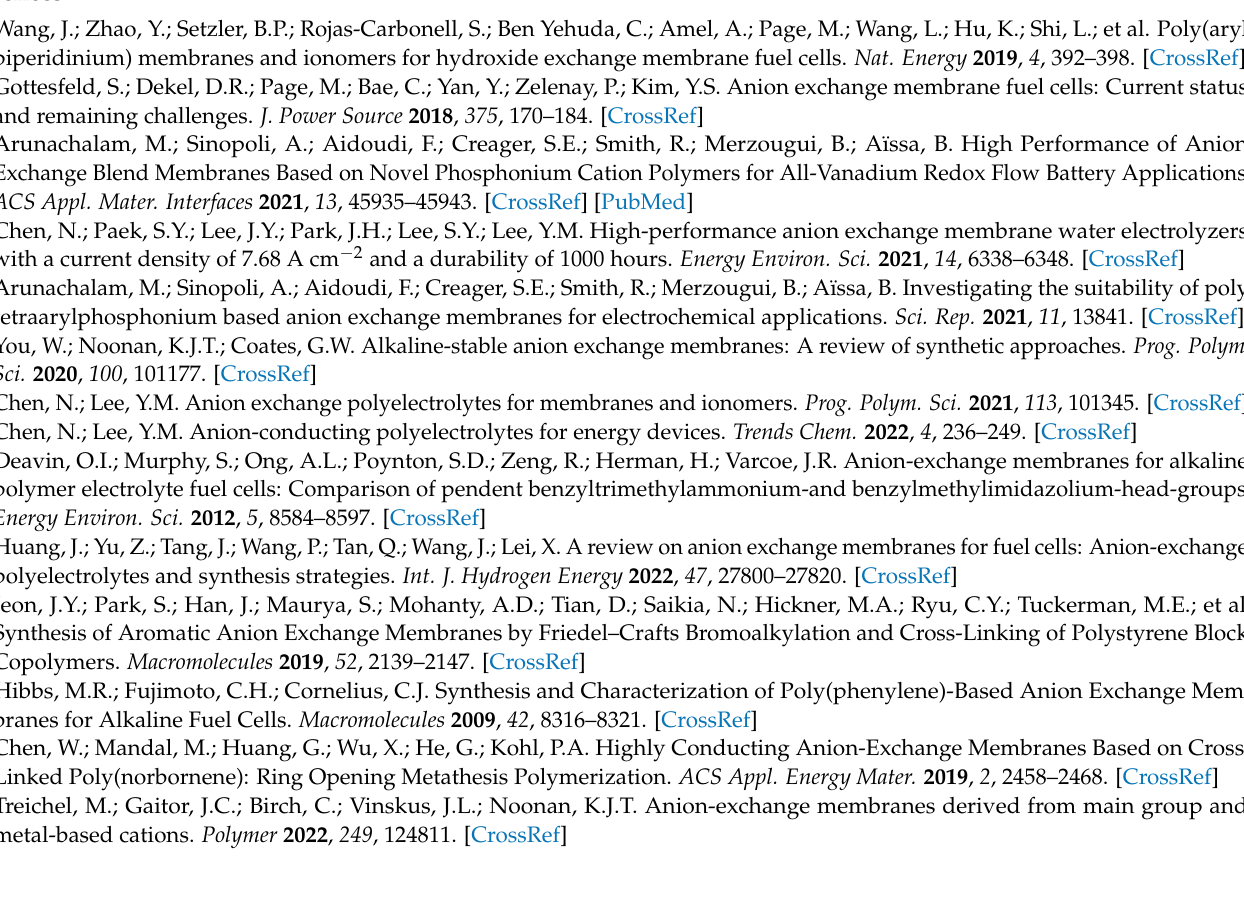
Figure S3. IEC remaining of the CPBTT-x AEMs after durability testing (1 M NaOH at 80 ◦ C